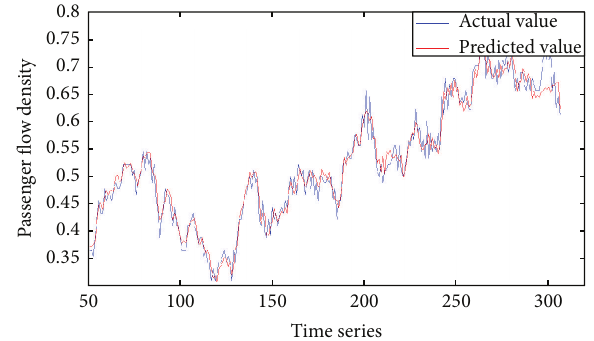
Figure 3: Comparison between actual value and forecasting value of passenger flow density based on RBF NN.